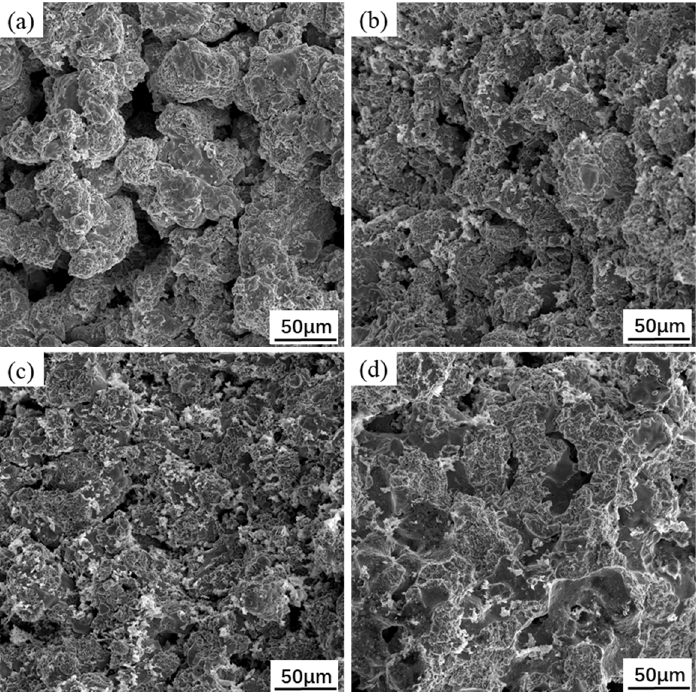
Figure 8. Fracture morphology of sintered porous NiTi specimen at various temperatures: ( a ) 950 °C; ( b ) 1000 °C; ( c ) 1050 °C; ( d ) 1100 °C.